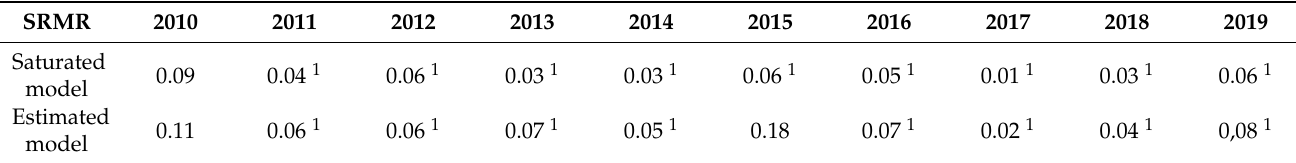
Table 3. Assessment of overall model